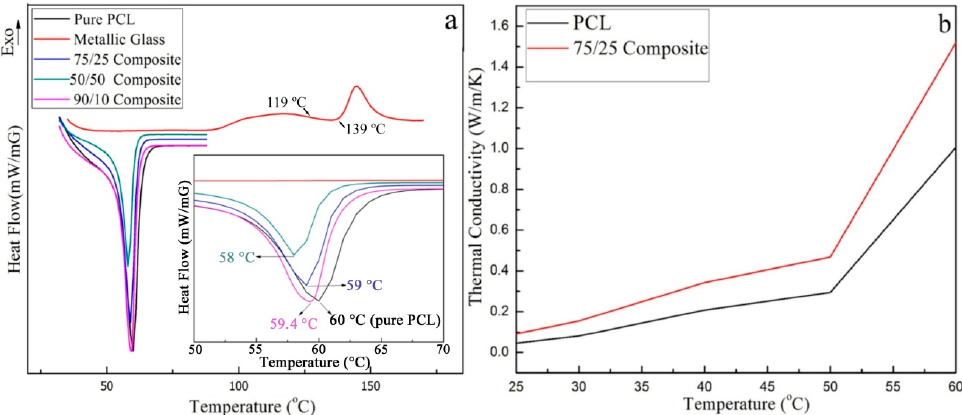
ff erent metallic